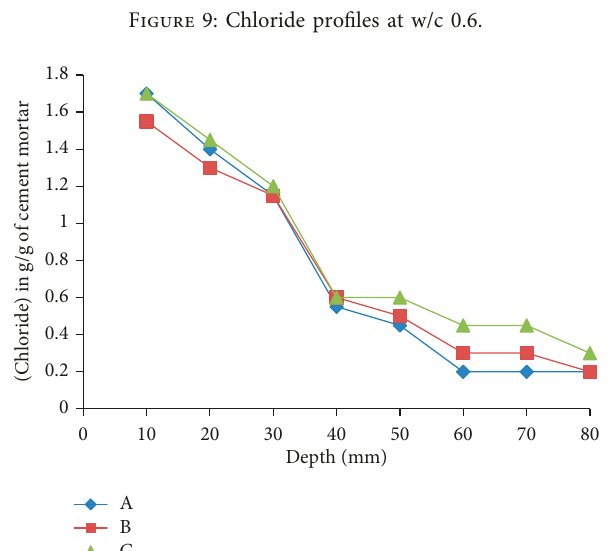
Figure 10: Chloride profile at w/c